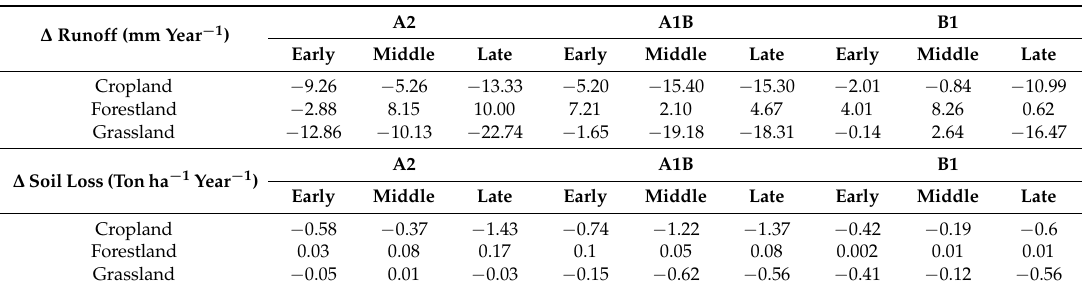
Table 6. Annual changes of runoff and soil loss of three major land covers in three future periods under three SRES